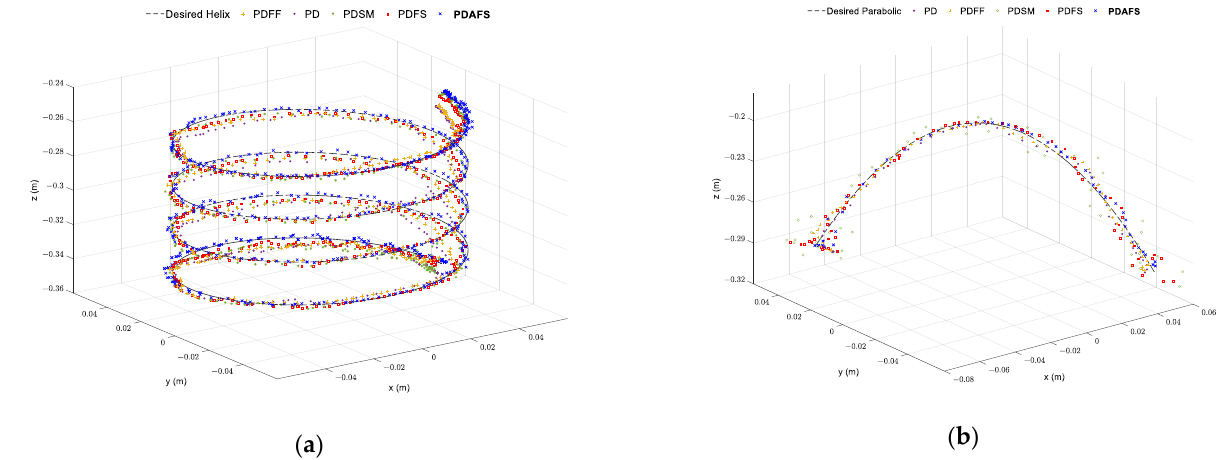
Figure 14. Tracking performance in workspace of case 1: ( a ) Helix trajectory; ( b ) parabolic trajectory.